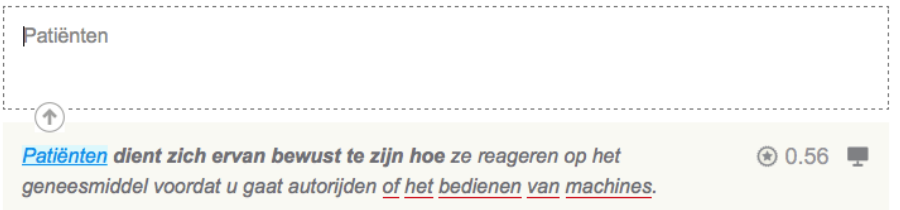
Figure 8. Quality estimation output in the SCATE user